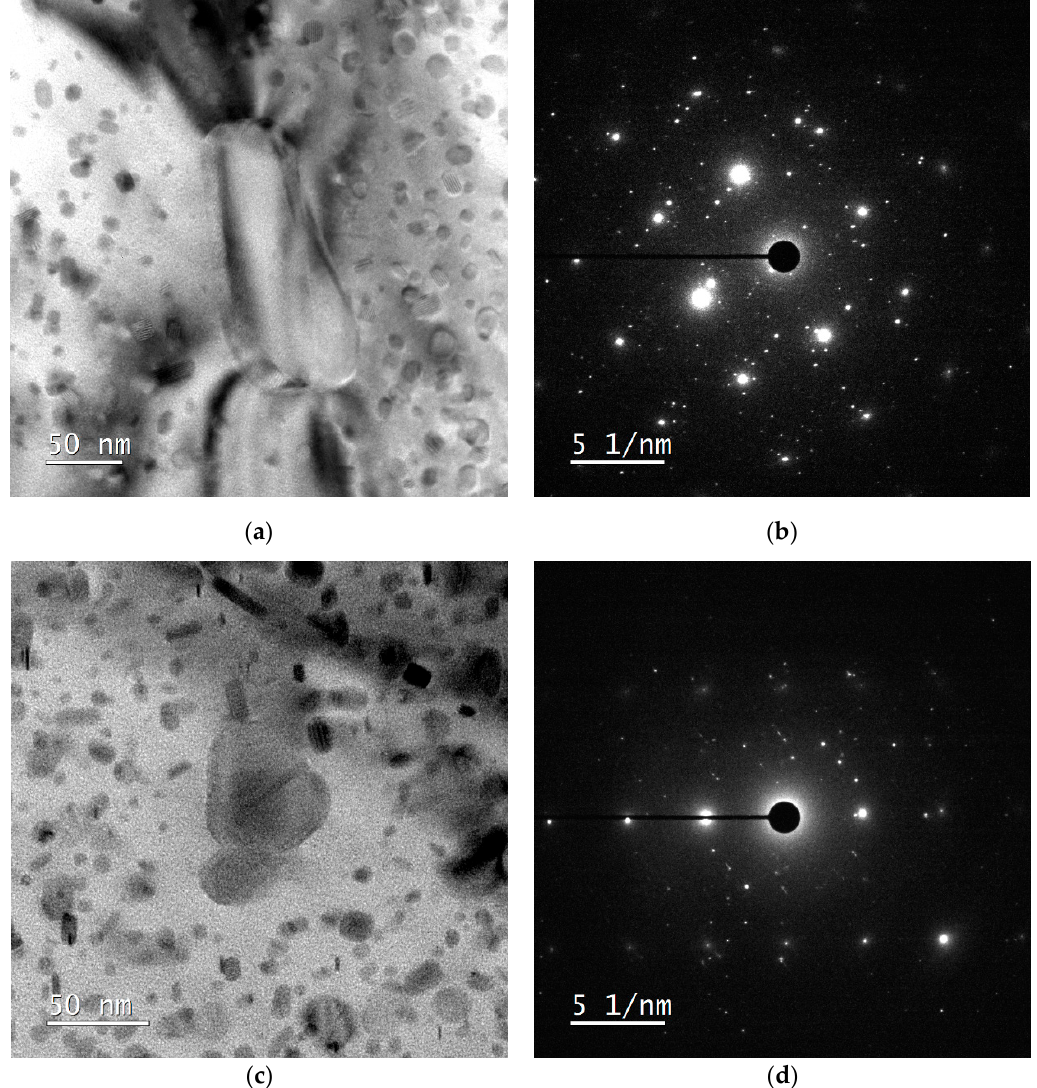
Figure 6. Al–Cu–Mg precipitates located and lined up at the grain boundaries in the matrix of the HC sample.